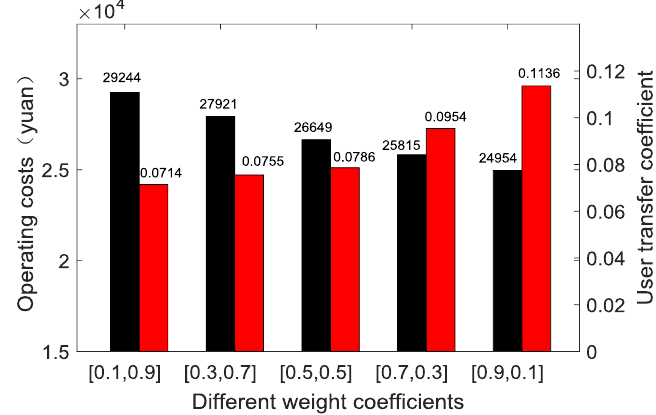
Figure 7. Different objective function values when different weights are applied. Figure 7. Di ff erent objective function values when di ff erent weights are applied.